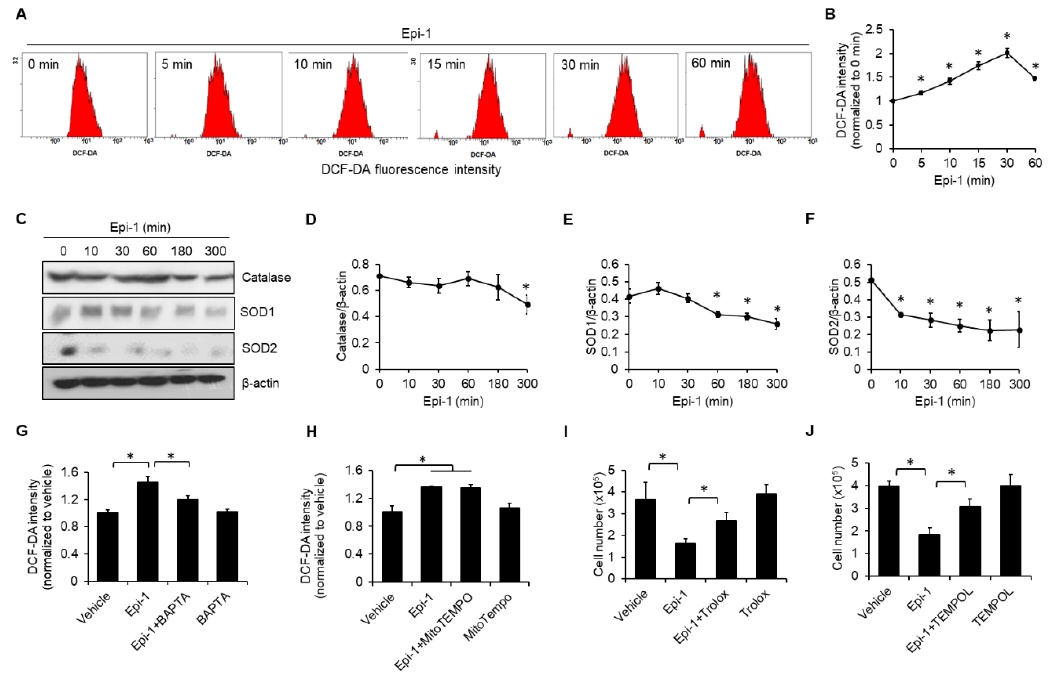
Figure 5. Epi-1 induces reactive oxygen species (ROS) generation and reduces expression of antioxidant proteins. ( A , B ) Cells were treated with epi-1 for di ff erent times, as indicated. ROS levels were monitored by DCF-DA (10 µ M) using flow cytometry. ( C ) Cells were treated with epi-1 as described in ( A ), cell lysates were collected and immunoblotted with anti-catalase, anti-SOD1, anti-SOD2, and anti- β -actin antibodies. ( D – F ) Band intensities were measured with ImageJ. Cells were preincubated with BAPTA (10 µ M) ( G ) and MitoTEMPO (10 µ M) ( H ) for 1 h, followed by epi-1 for an additional 30 min. Fluorescence intensity of DCF-DA was assessed by flow cytometry. Cells were preincubated with Trolox (100 µ M) ( I ) and TEMPOL (150 µ M) ( J ) for 1 h, followed by epi-1 for an additional 5 h. Cytotoxicity was scored by the trypan blue exclusion assay. * p < 0.05 was considered significant.